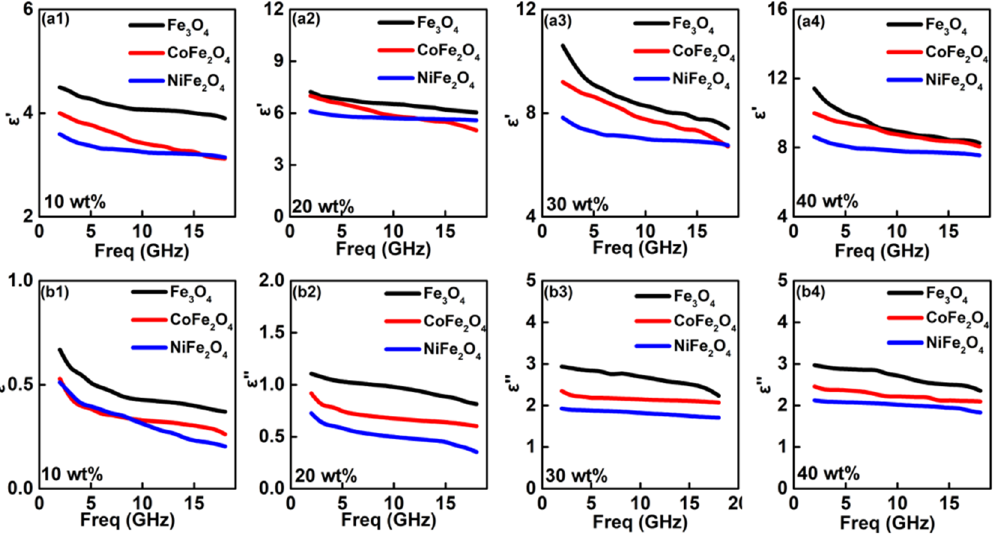
Figure 4. Frequency dependency of permittivity values for the absorption layer with various con-